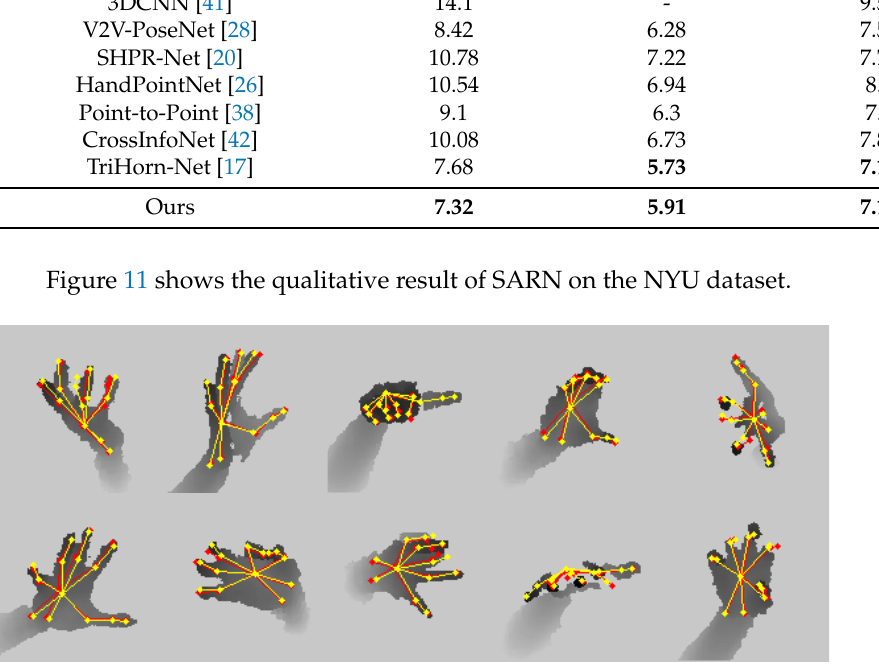
Figure 11. Qualitative results on NYU dataset. Ground truth is shown in red, and the prediction is in yellow.